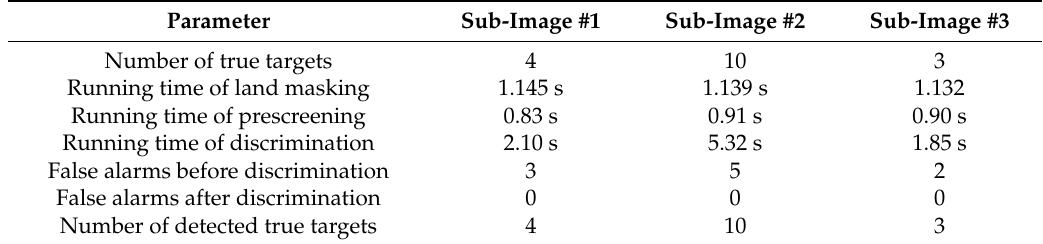
Table 6. The running time of each stage and detected results of the proposed method.